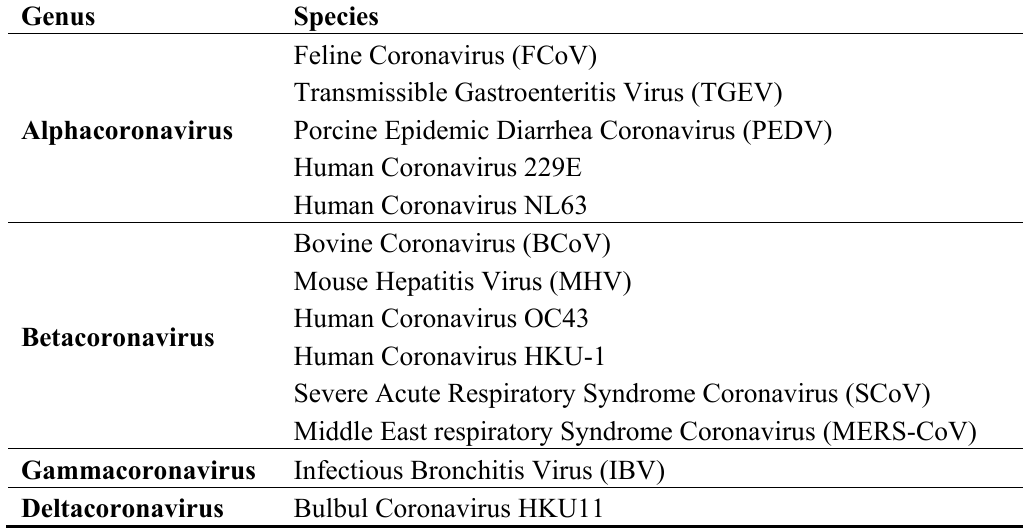
Table 1. Coronavirus genus, species, and virus